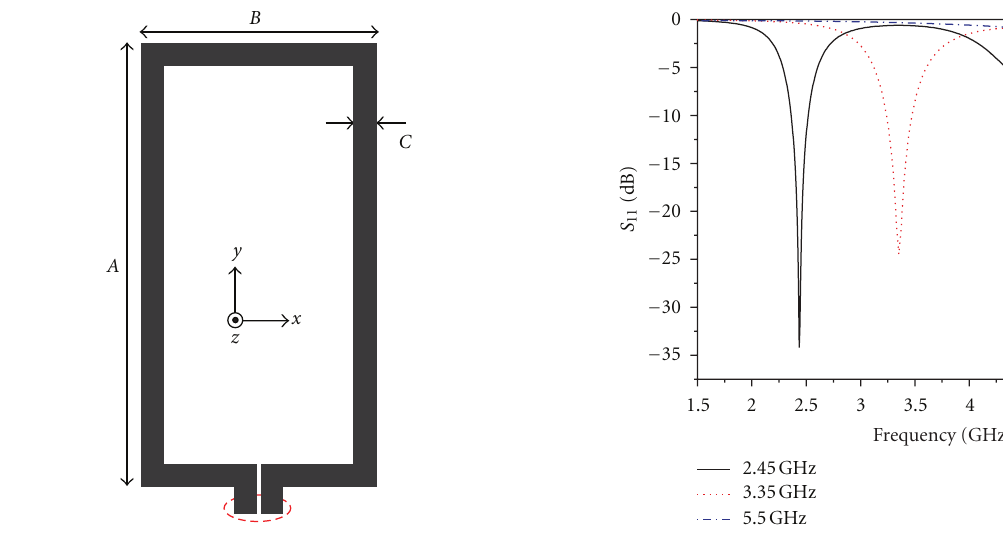
Figure 9: S 11 results of the rectangular loop antennas with each operating